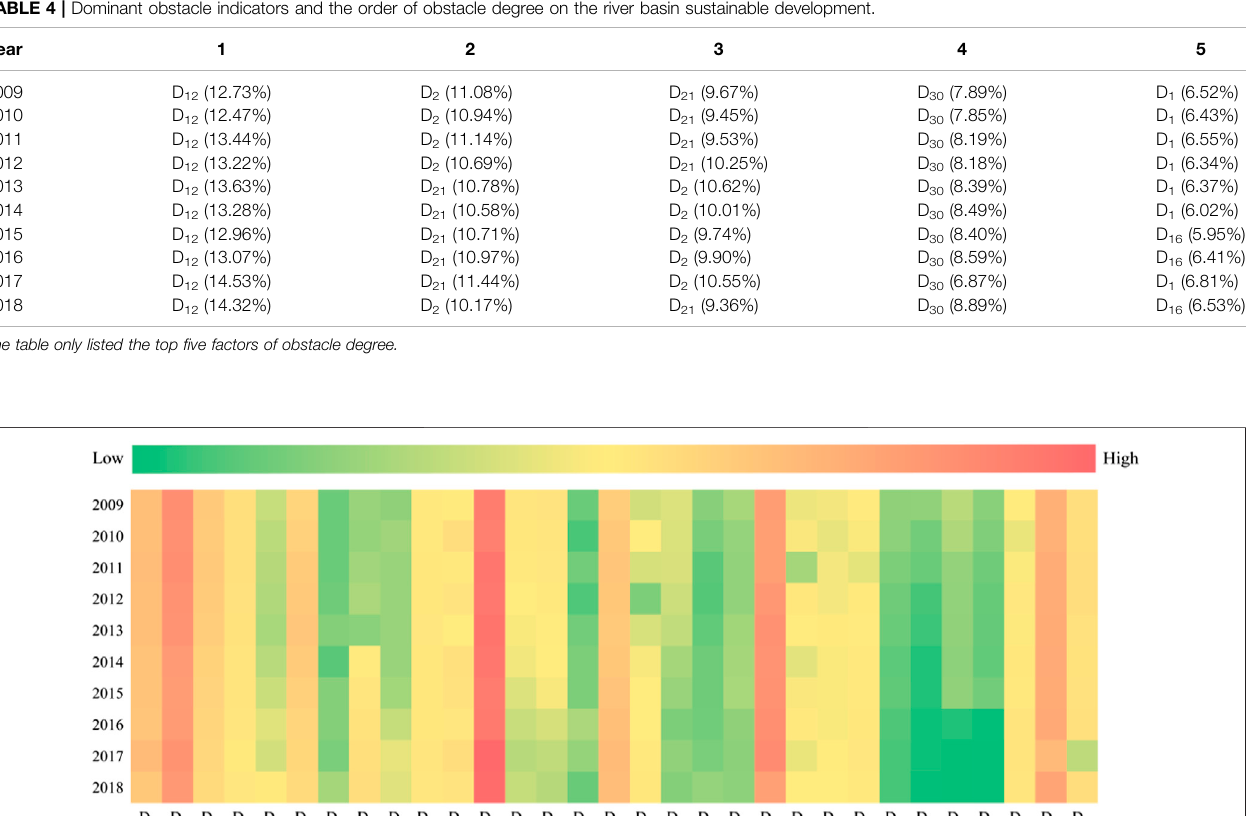
TABLE 4 | Dominant obstacle indicators and the order of obstacle degree on the river basin sustainable development.